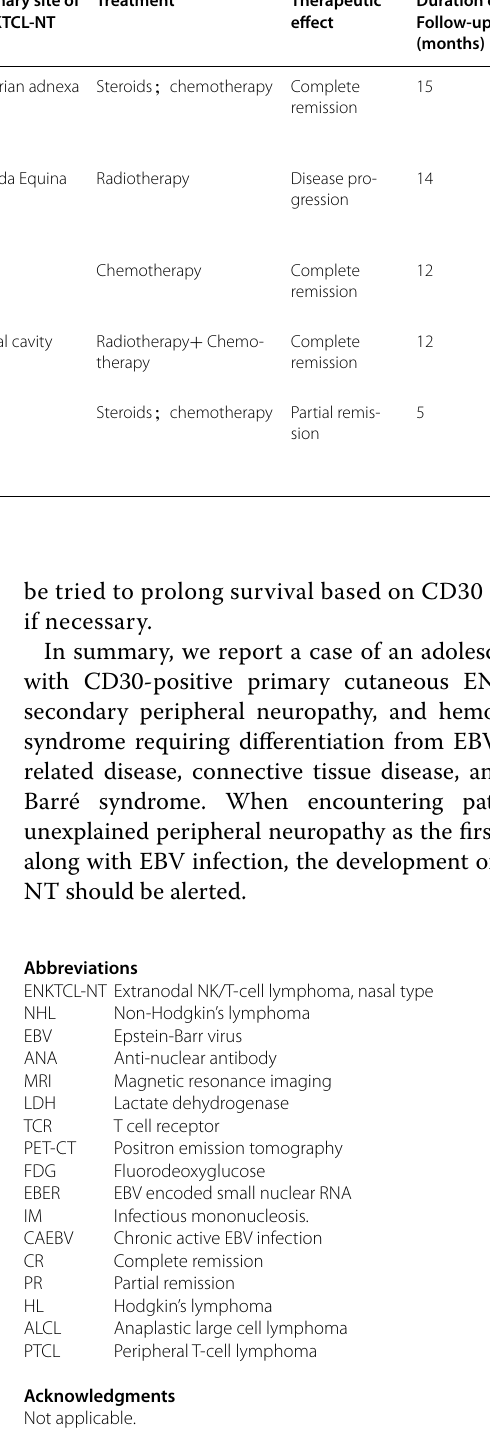
Table 1 Clinical characteristics of patients with ENKTCL-NT combined with peripheral neuropathy Authors, year Age/Sex